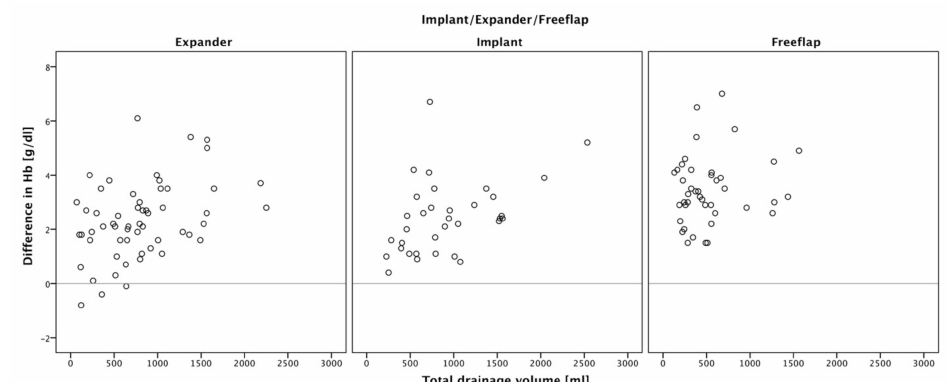
Figure 6. Scatter plot correlation analysis of hemoglobin levels and drainage fluid output within the groups: no significant correlation of increased drainage fluid output could be observed in our patients (tissue expander: τ b = 0.26, p = 0.00434, N = 57; definitive implants: τ b = 0.28, p = 0.01979, N = 34; free tissue flaps: τ b = 0.08, p = 0.474, N = 42). Only within the tissue expander and definitive implant group a weak correlation could be seen. Simultaneously, hemoglobin level decrease only appeared to be minimal in these two groups.